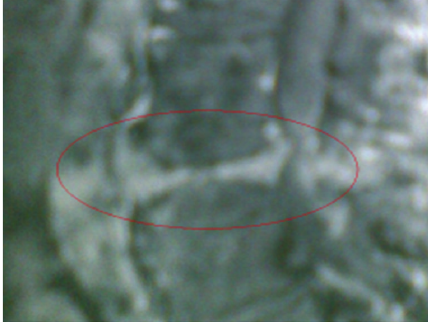
Figure 5: Protein S100 positivity on the immunohistochemical